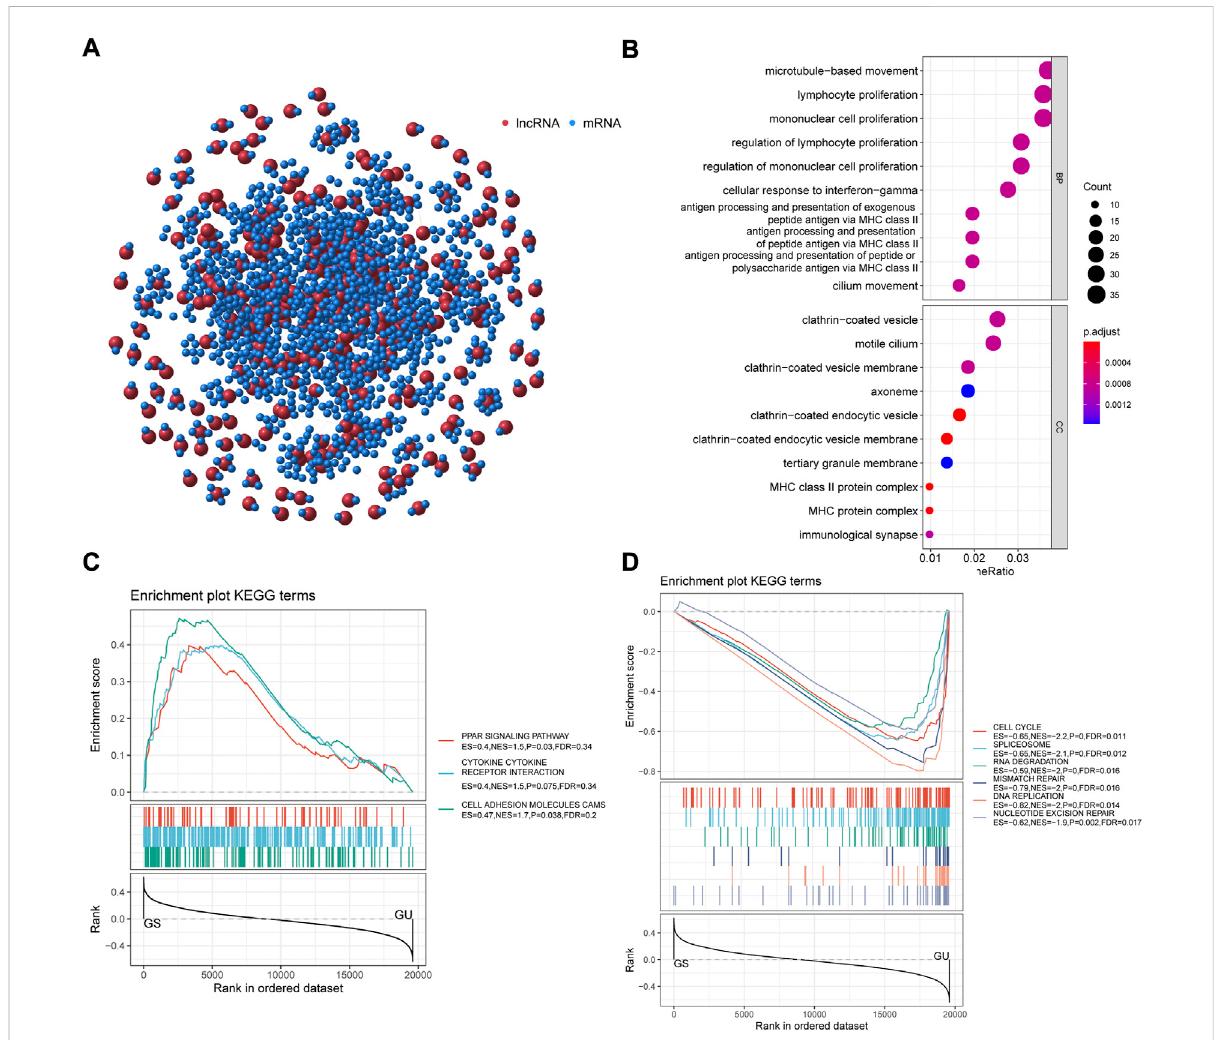
FIGURE 4 . lncRNA-mRNA co-expression network and functional enrichment analysis. (A) Co-expression network of mRNAs and lncRNAs, with red dots representing lncRNAs and blue dots representing mRNAs. (B) Bubble plot of GO analysis of differential AS events. (C – D) KEGG analysis plot of lncRNA-correlated PCGs. GO, gene ontology; KEGG, Kyoto Encyclopedia of Genes and Genomes; PCGs, protein-coding